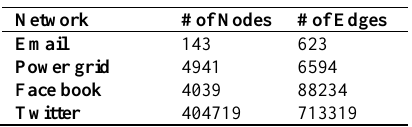
Table 2. Details of real-world networks without ground truth of communities. Network